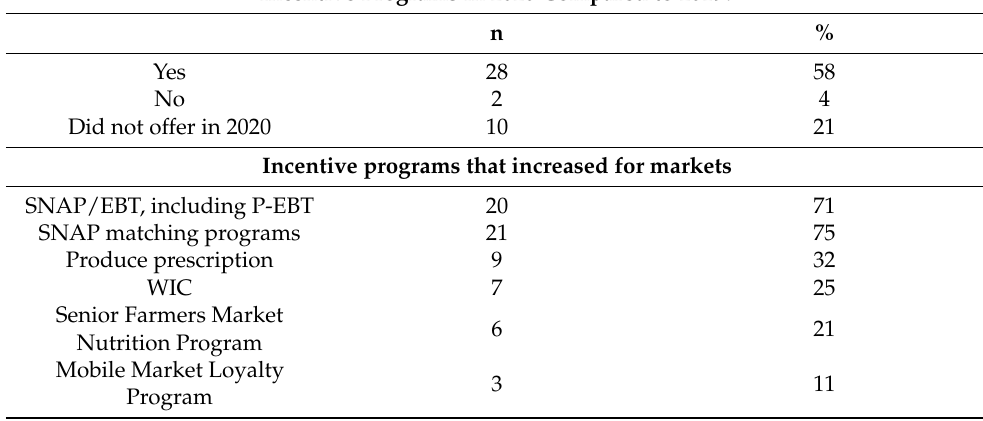
Table 11. Fruit and Vegetable Incentive Program Usage.